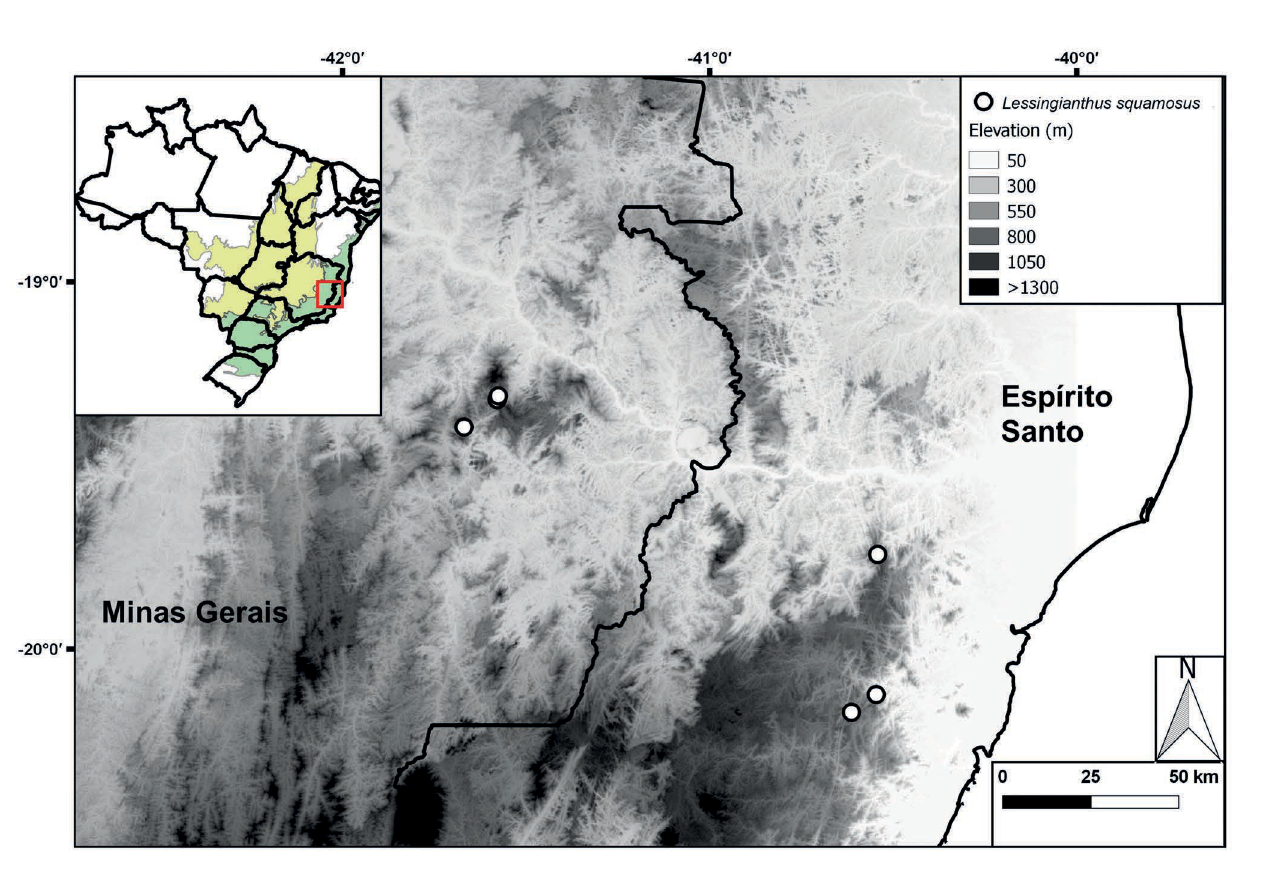
Figure 6 – Distribution of Lessigianthus squamosus M.Monge & Semir. In the inset map, the yellow area shows the extension of the Cerrado domain and the green area show the extension of the Atlantic Forest domain. Map created with QGIS v.3.0.1 (QGIS Development Team